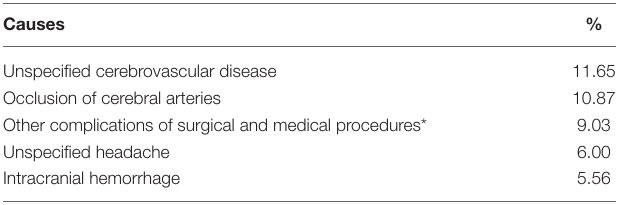
TABLE 4B | Top causes of readmission in endovascular population (Weighted N = 194). Causes